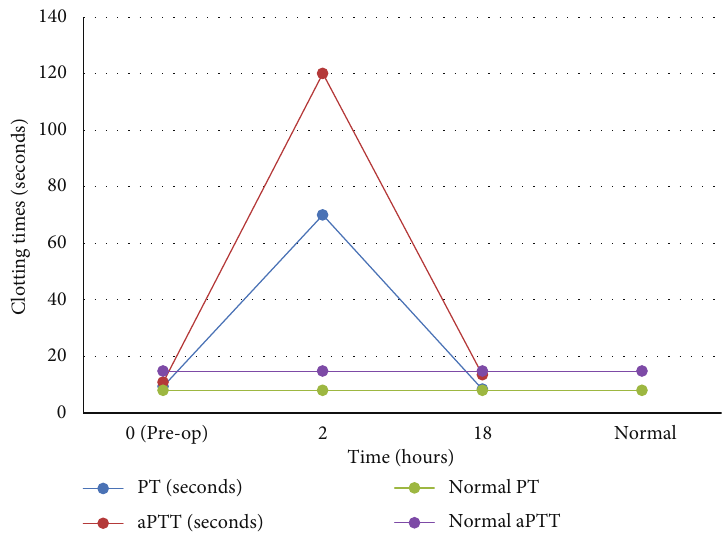
Figure 3: Coagulation parameters (PT and aPTT) following intra-articular PPS administration in case